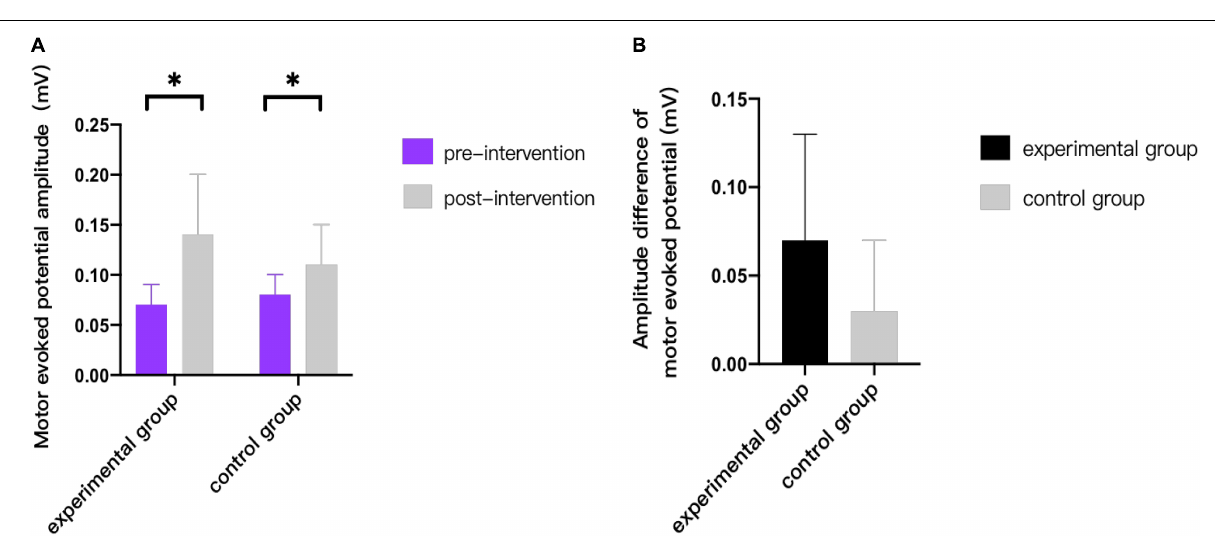
FIGURE 7 | Comparison of latency of motor evoked potentials. * indicates intra-group p < 0.05, and # indicates inter-group p < 0.05.